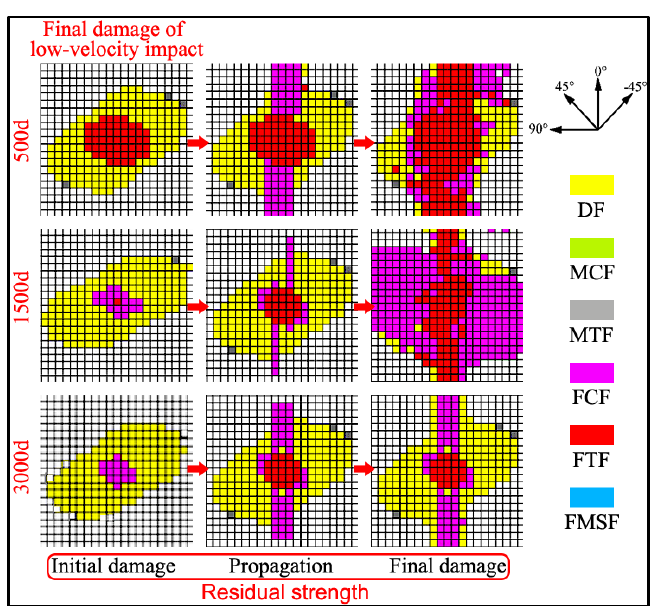
Figure 14. Progressive damage processes of the laminates after the impact of 10 J.